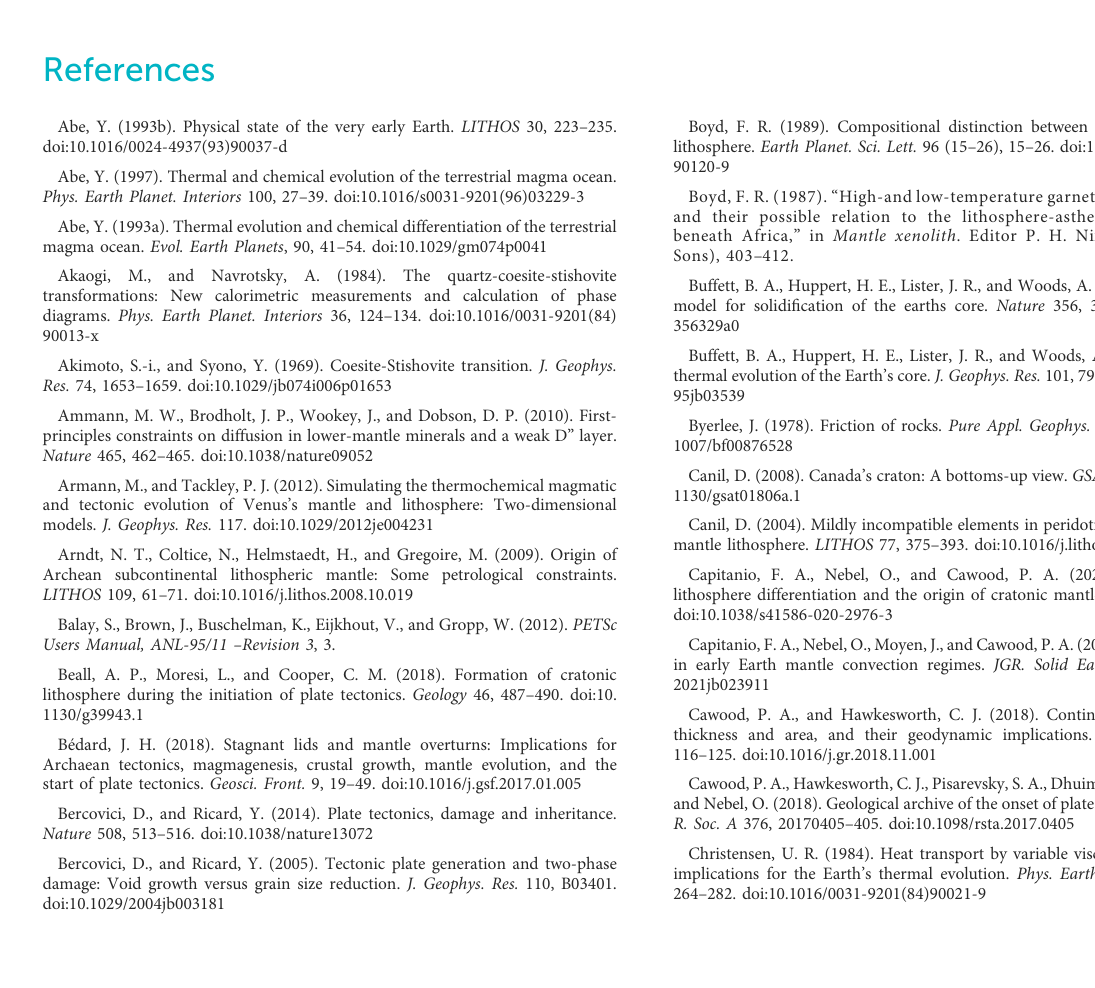
SUPPLEMENTARY VIDEO S1 Evolution of simulation A13. SUPPLEMENTARY VIDEO S2 Evolution of simulation